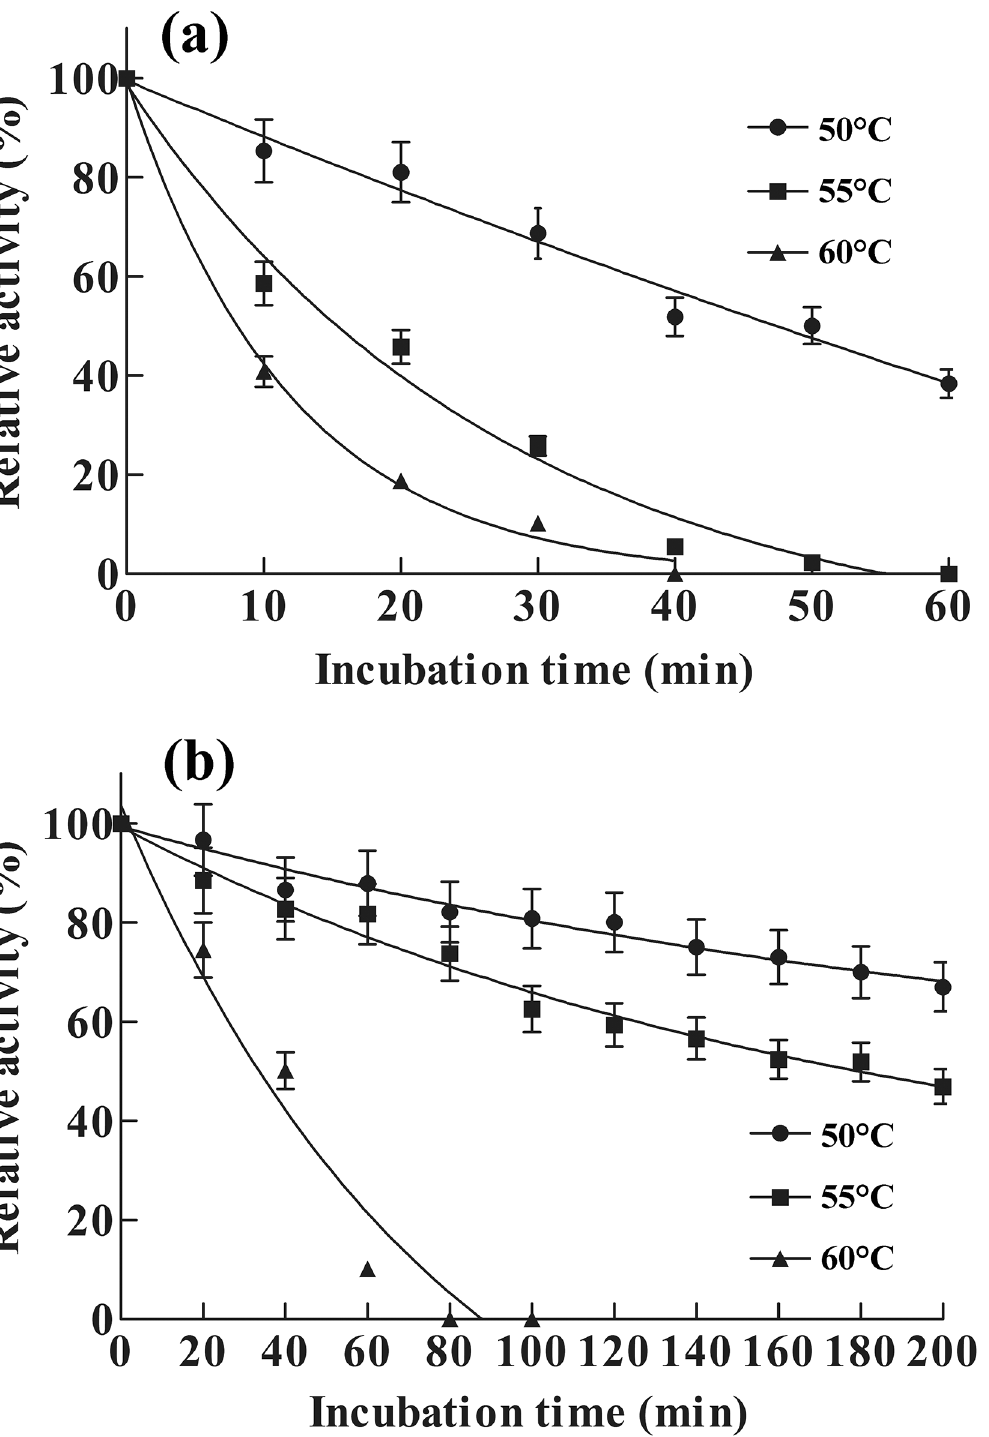
Fig 6. Thermostability of the re-AuFaeA and re-AuFaeA A126C-N152C . Thermostability of (a) re-AuFaeA and (b) re-AuFaeA A126C-N152C were evaluated by incubating in the absence of substrate at temperatures ranging from 50 to 60°C for different time, respectively, and the residual enzyme activities were measured under the standard assay